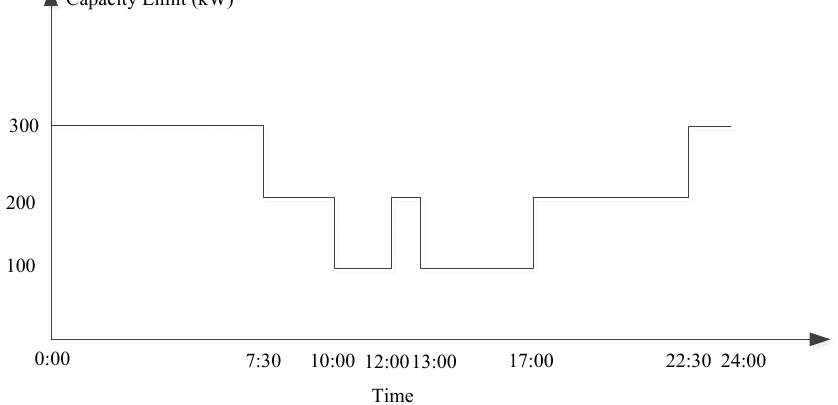
Figure A1. Capacity limit at each time interval for the usual contracted capacity 100 kW, half-peak contracted capacity 100 kW, and off-peak contracted capacity 100 kW.